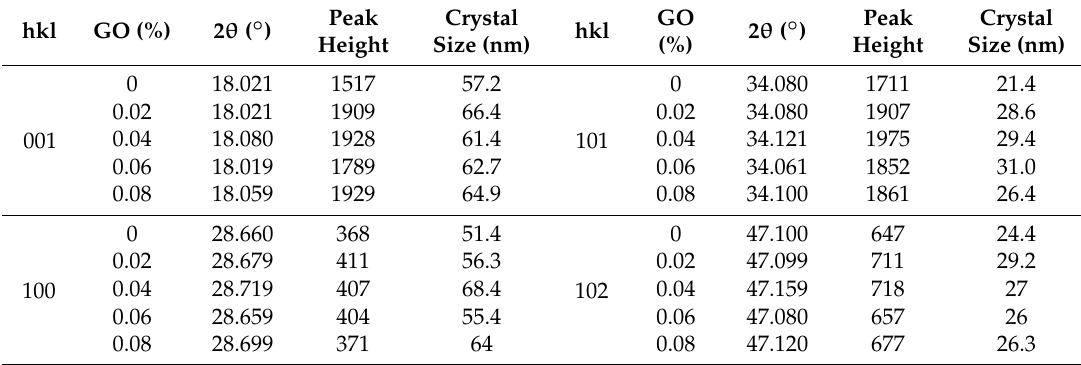
Table 2. CH diffraction peak intensity and crystal size at 3 days.